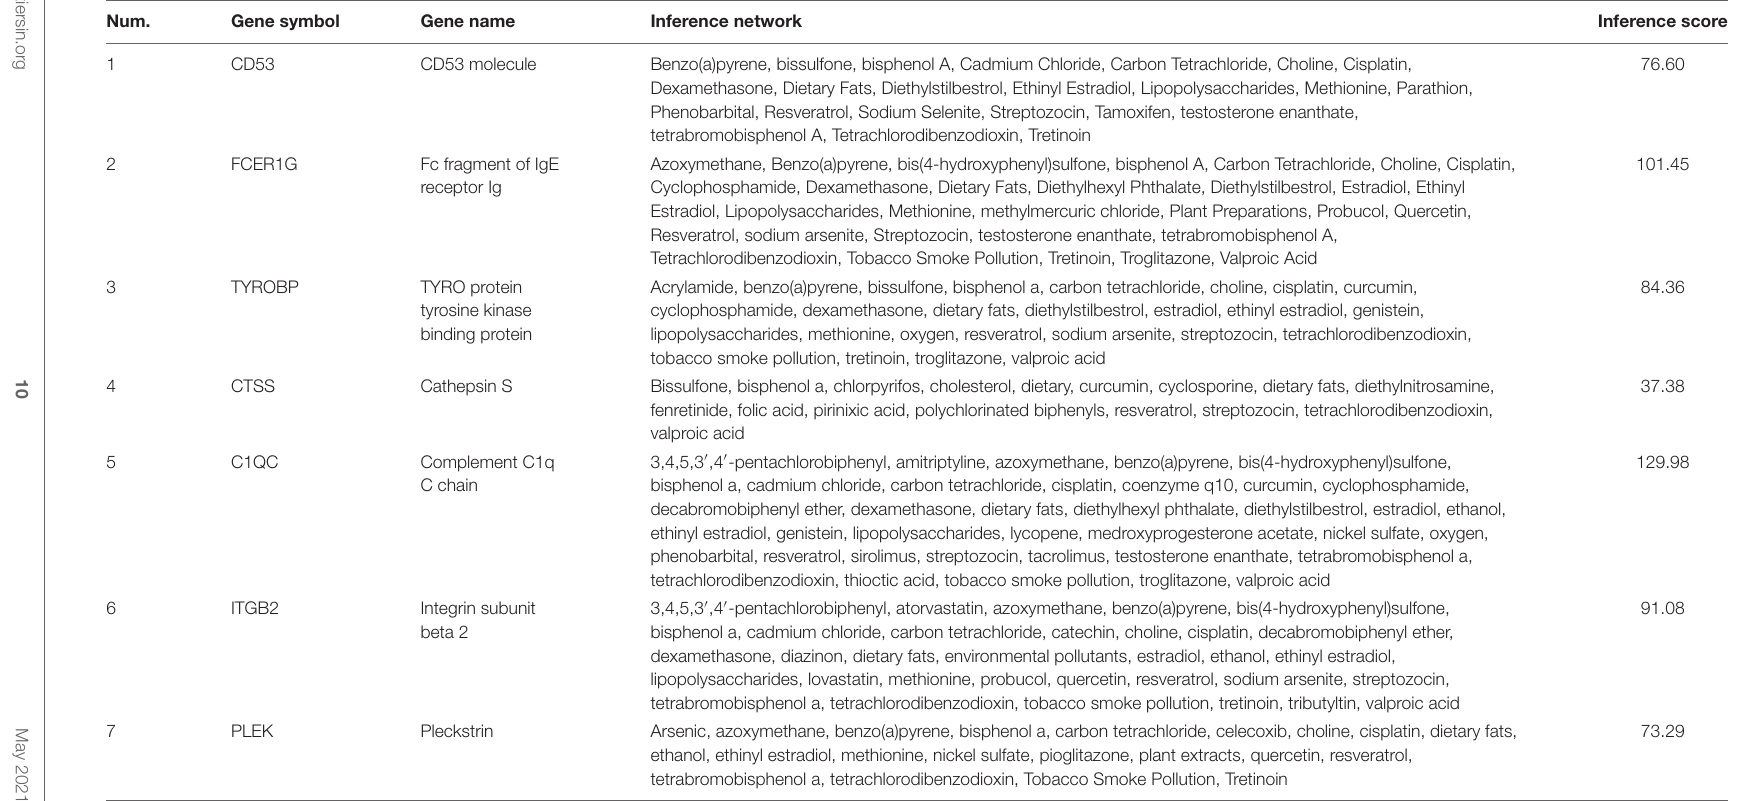
TABLE 4 | Chemicals associated with obesity and weight gain.